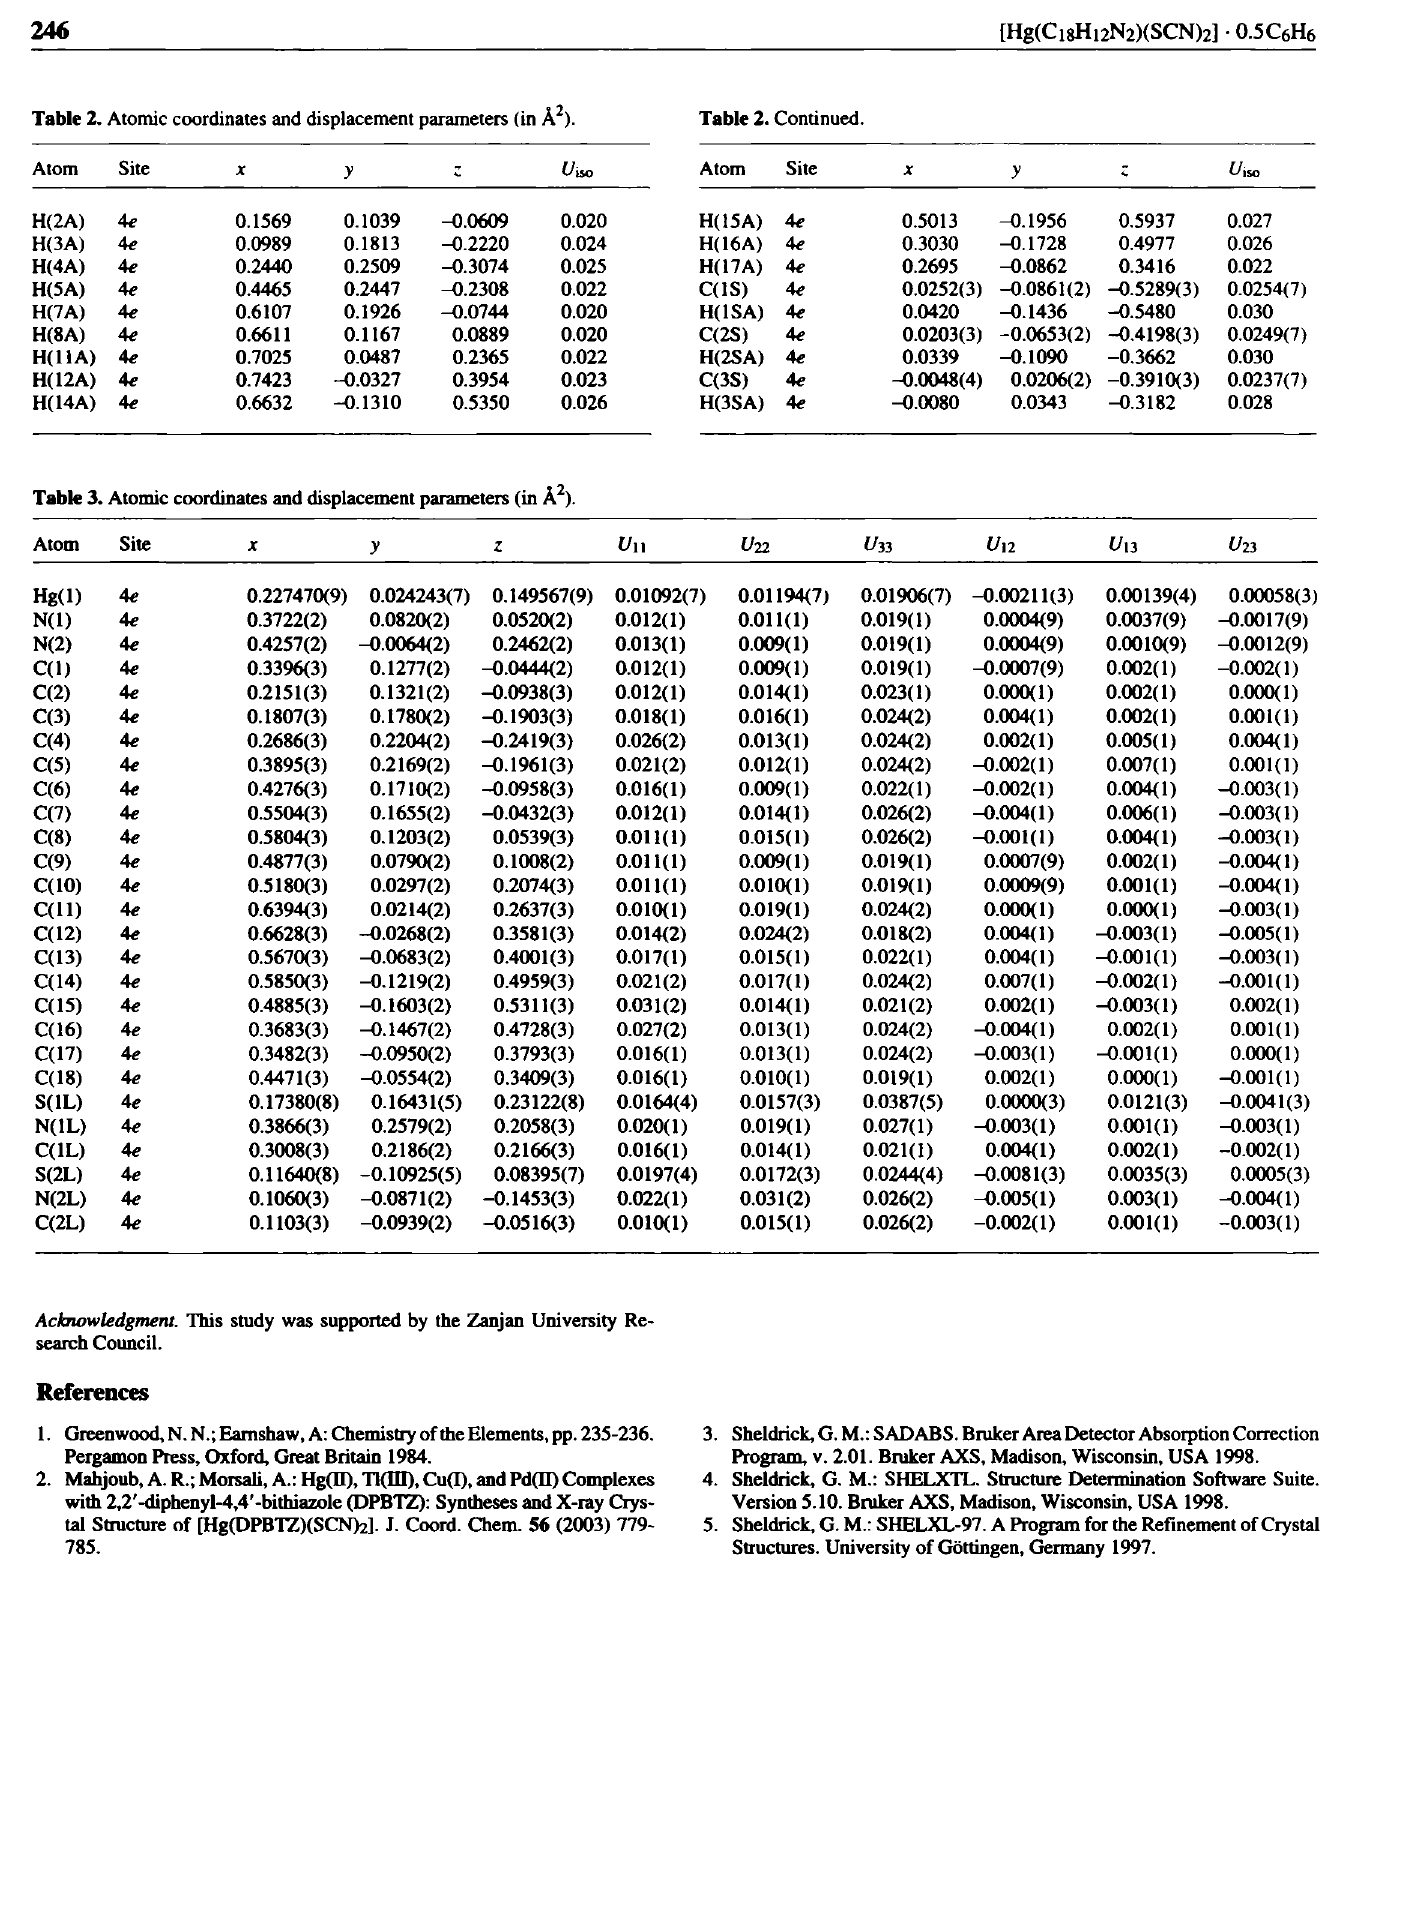
Table 3. Atomic coordinates and displacement parameters (in Â 2